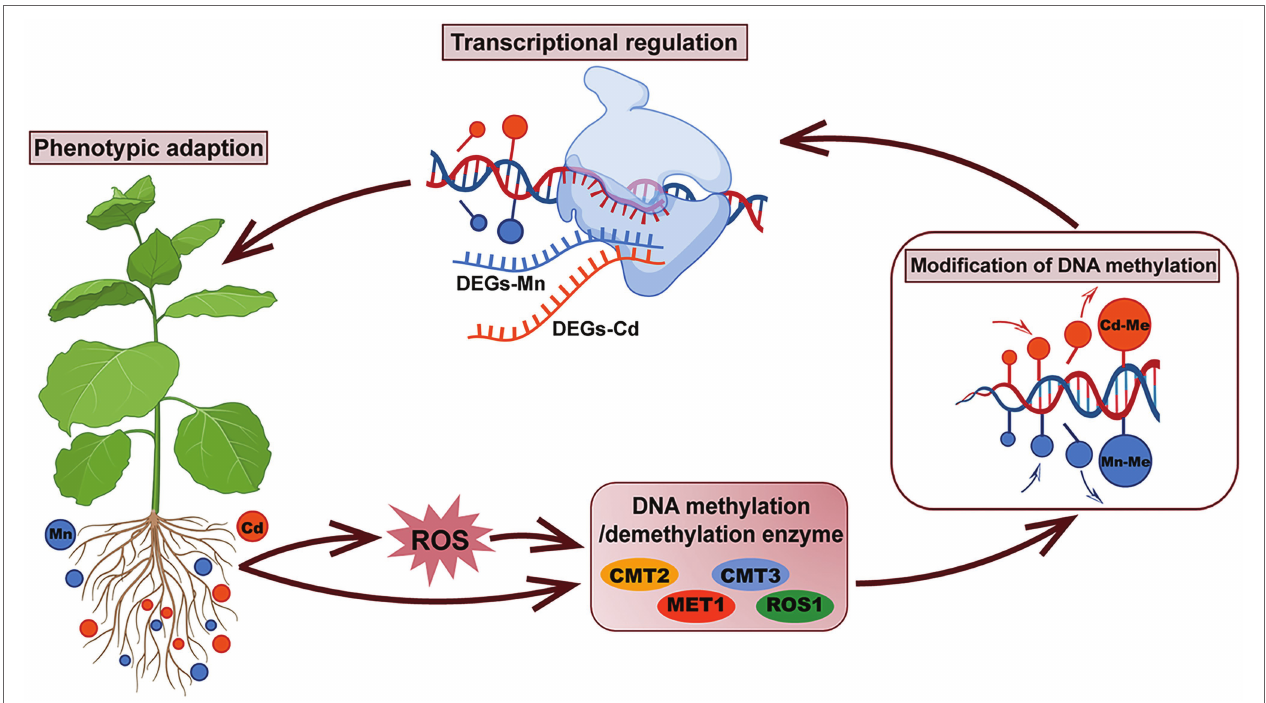
FIGURE 8 | A schematic summary of the phenotypic adaption of pokeweed under Mn and Cd stress mediated by DNA methylation and transcriptional regulation. In pokeweed, DNA methylase and demethylase were differently expressed caused by Mn and Cd stress directly or mediated by Mn/Cd-induced ROS indirectly. The different expressions of DNA methylase and demethylase further triggered different modification of DNA methylation leading to Mn- and Cd-specific DNA methylated loci, which showed that partial changes in DNA methylation under Mn/Cd stress were mediated by Mn/Cd-induced ROS. The Mn- and Cd-specific DNA methylated loci further distinguished Mn and Cd with different transcriptional patterns and finally induced different phenotypes responses to Mn and Cd